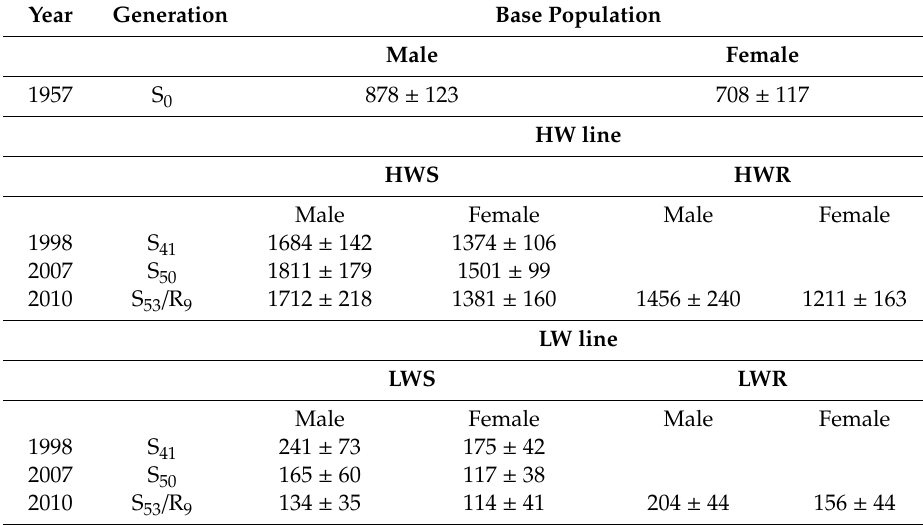
Table 1. 56-day body weights of the Virginia high weight (HW) and low weight (LW) chicken lines (S—selected, R—relaxed). Reported are generation means (grams ± standard deviations) for males and for females. Presented are data from the founder population (generation S0) and for the generations of the HW and LW lines included in this study (generations S41, S50 and S53 /